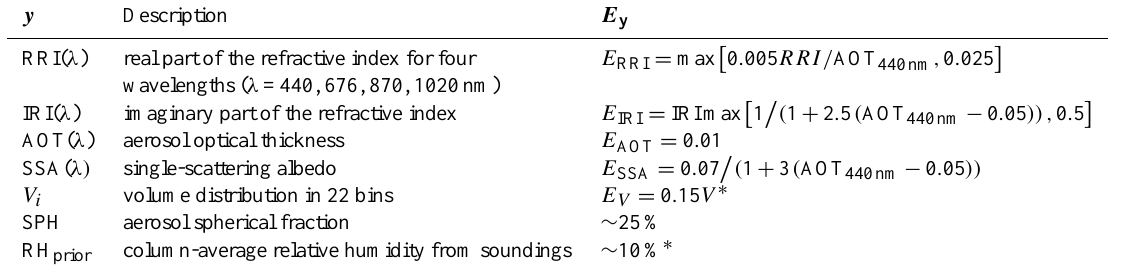
Table 1. Overview of the parameters in the state vector ( x ). Subscripts f and c denote fine and coarse mode, respectively. x Description Remarks m f , m c (SO 4 ) column-average mass mixing ratio sulfate The inorganic composition is determined from sulfate by using (fixed) ammonium-to-sulfate and nitrate-to-sulfate ratios (see text). mass mixing ratio organic carbon Water uptake is determined assuming 20%wt levoglucosan, 40%wt succinic acid and 40%wt Suwannee River reference fulvic acid (Sven- ningsson et al., 2006). – – Fine- and coarse-mode aerosols are assumed to be lognormally dis- tributed. Geometric standard deviation of each mode can be varied by the model. Only used when the (440–870nm) Ångström exponent is < 1.2 and the AOT is > 0.1, otherwise SPH=1. Initial guess is derived from sounding data. Table 2. Overview of the parameters in the measurement vector ( y ) and the uncertainties E y in y used in this study.